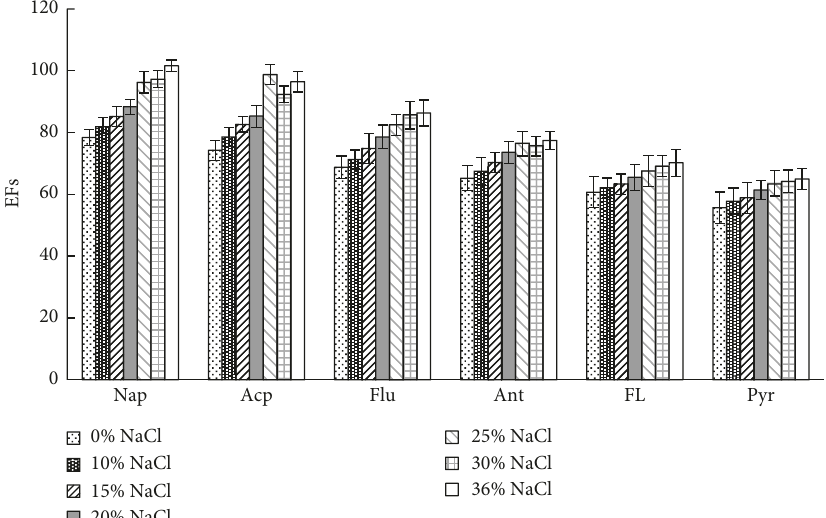
Figure 6: The effect of NaCl% on EFs. Other extraction conditions: 10mL of aqueous standards (containing PAHs at a concentration Table 2: Main analytical parameters for the enrichment of PAHs with the proposed method.